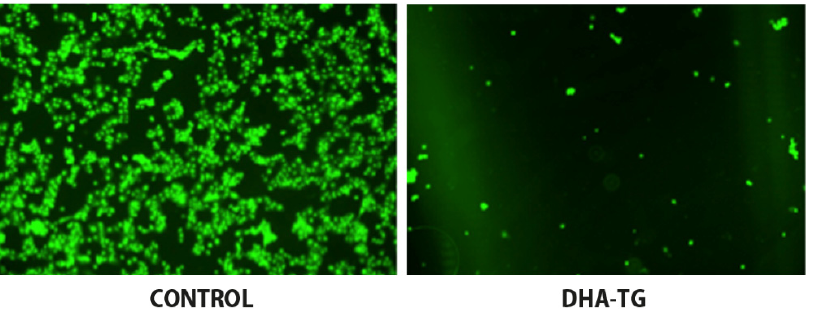
Figure 2. Retinal ARPE-19 cells ( × 10 magnification) showing disappearance of oxidation of fluorescent probes by DHA triglyceride (DHA-TG) (right) as compared with control (left) as indicative of removal of intracellular ROS (reactive oxygen species).